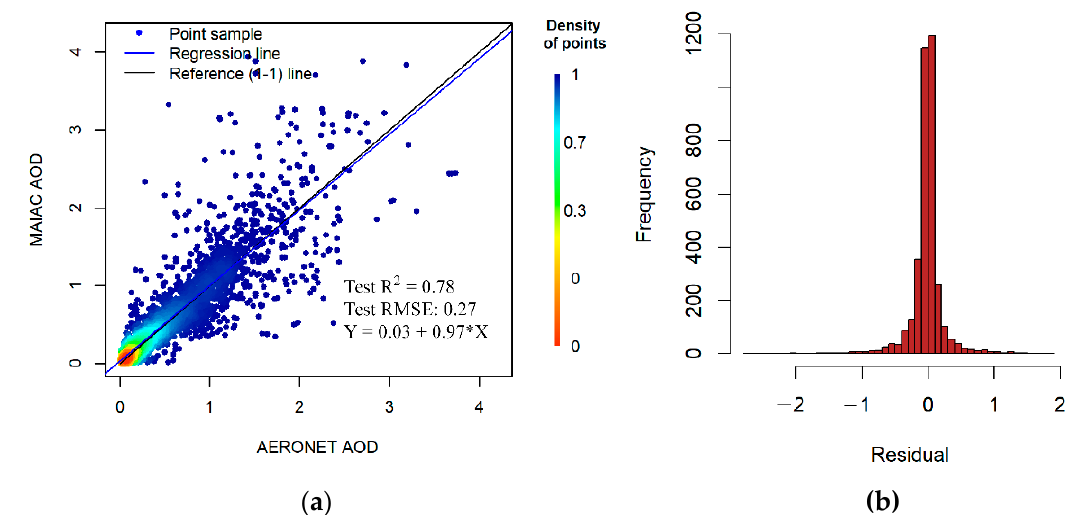
Figure 6. Scatter plot of training and testing R 2 ( a ) and a histogram of the residuals ( b ) in the imputation of MAIAC AOD of 2015–2018.